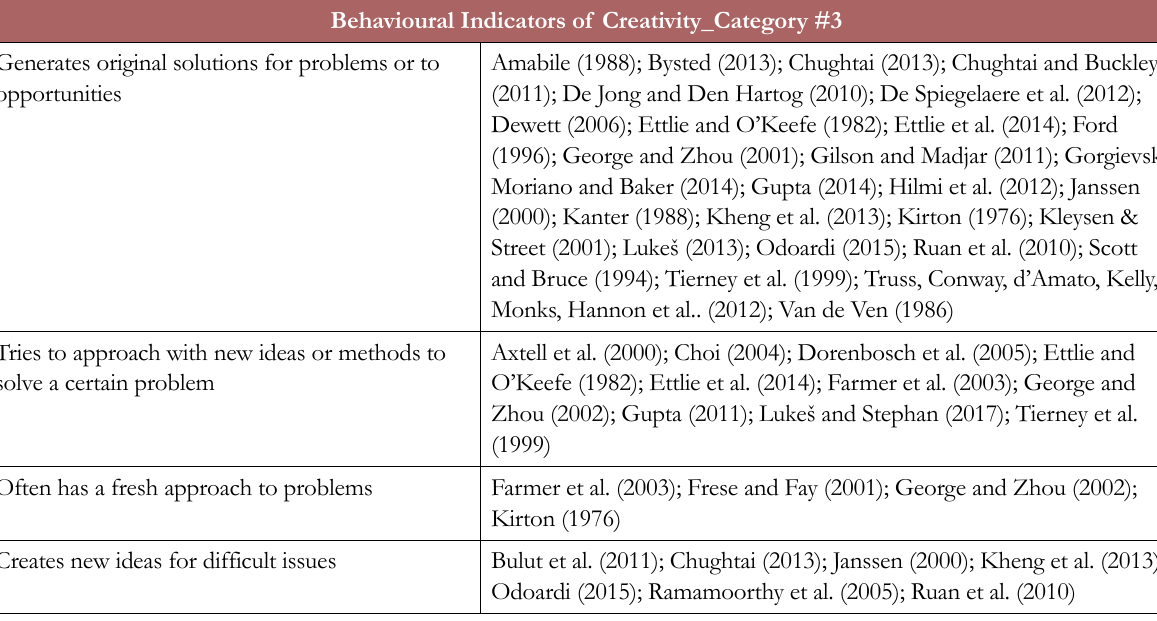
Table 5. Behaviours showing “problem-solving”